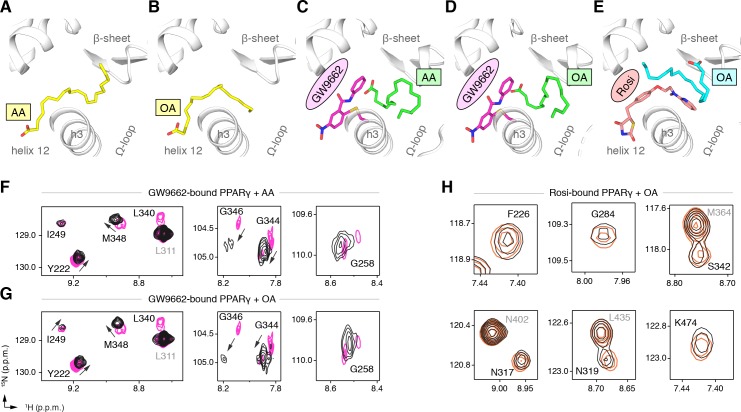
Cobinding of endogenous UFAs and synthetic PPARγ ligands.(A,B) UFA ligand binding poses in crystal structures of PPARγ LBD (chain A) bound to (A) AA and (B) OA. (C–E) Ligand binding poses in crystal structures obtained from UFA-bound co-crystals soaked with synthetic ligands, including (C) AA-bound PPARγ LBD soaked with GW9662, (D) OA-bound PPARγ LBD soaked with GW9662, and (E) OA-bound PPARγ LBD soaked with rosiglitazone. (F,G) Differential 2D [1H,15N]-TROSY-HSQC NMR data of PPARγ LBD covalently bound to GW9662 (magenta) confirming cobinding with (F) AA (black; one equiv.). and (G) OA (black; one equiv.). (H) Differential 2D [1H,15N]-TROSY-HSQC NMR data of PPARγ LBD bound to rosiglitazone (pink; two equiv.) confirming cobinding with OA (black; one equiv.). Black arrows denote the chemical shift changes in the NMR data. Also see
Figure 9—figure supplements 1 and 2.